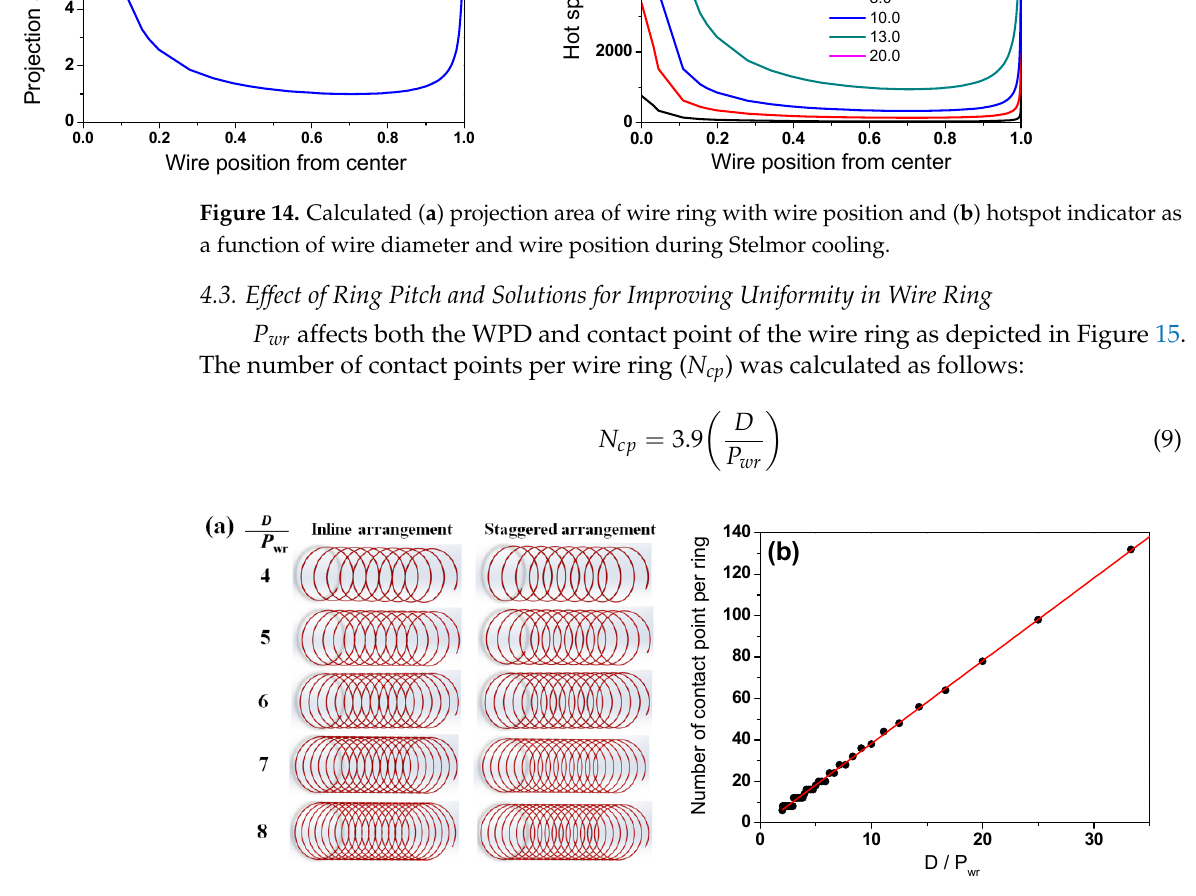
Figure 15. ( a ) Schematic and ( b ) calculated number of contact points in wire ring as a function of ring pitch in Stelmor cooling.